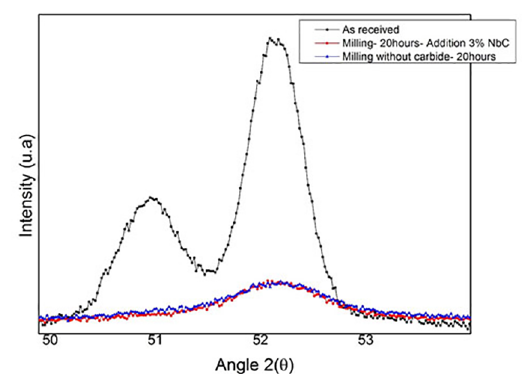
Figure 9. X-ray diffraction Figure 7 details showing only the ferrite, austenite and marten-site phase peaks for the regions of 2(θ) between 50 and